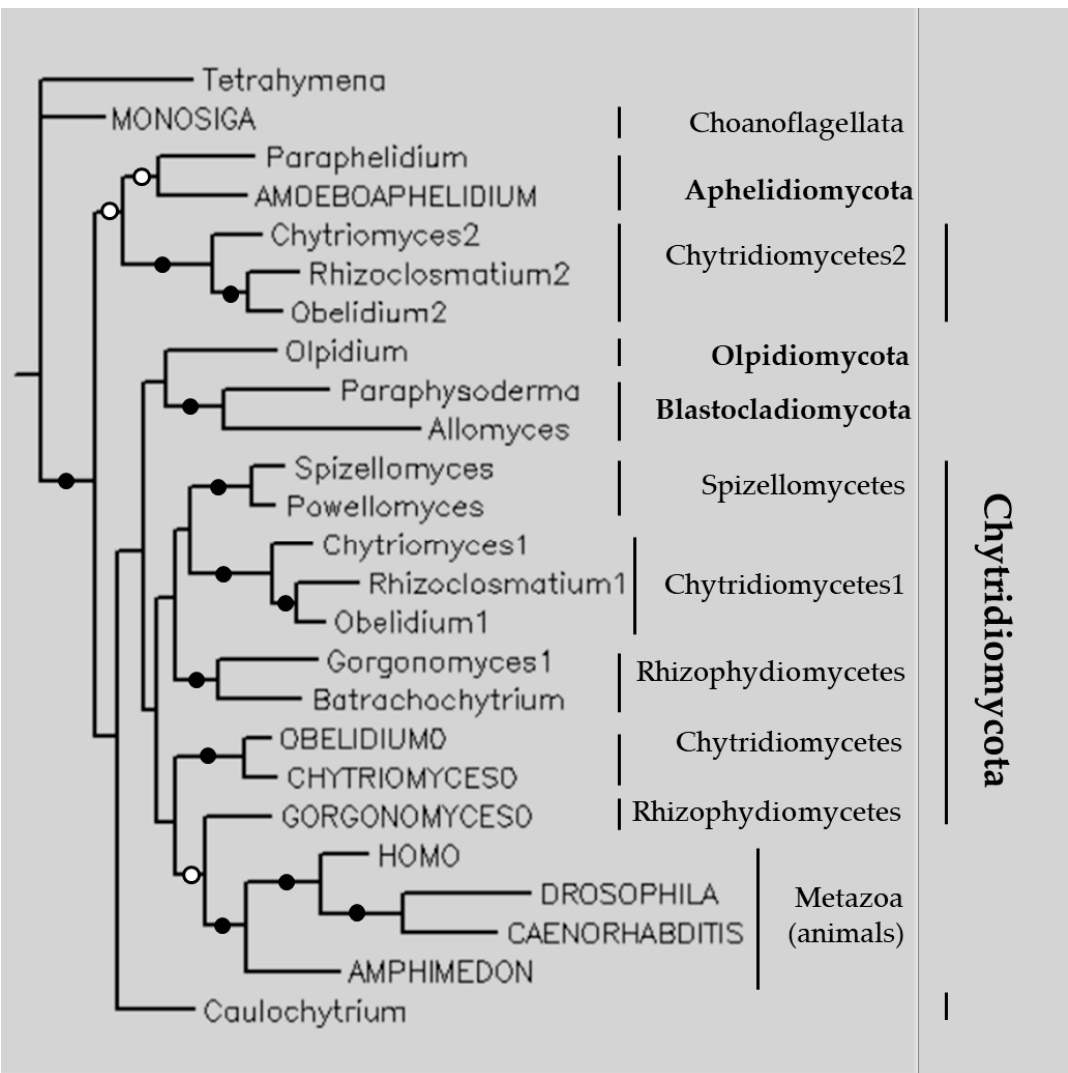
Figure 4. The phylogenetic tree of some TPPPs constructed by Bayesian analysis [16]. The number of generations was 1.4 × 10 − 6 . Full and open circles at a node indicate that the branch was supported by the maximal Bayesian posterior probability (BPP) and ≥ 0.95 BPP, respectively. All the other branches were supported by BPP ≥ 0.5. The accession numbers of proteins are listed in Table S3. Uppercase letters indicate animal-type TPPPs, lowercase letters indicate fungal-type ones, except for the outgroup Tetrahymena thermophila TPPP (XP_001023601) (phylum Ciliophora), which is a short-type TPPP. Fungal phyla are indicated by bold